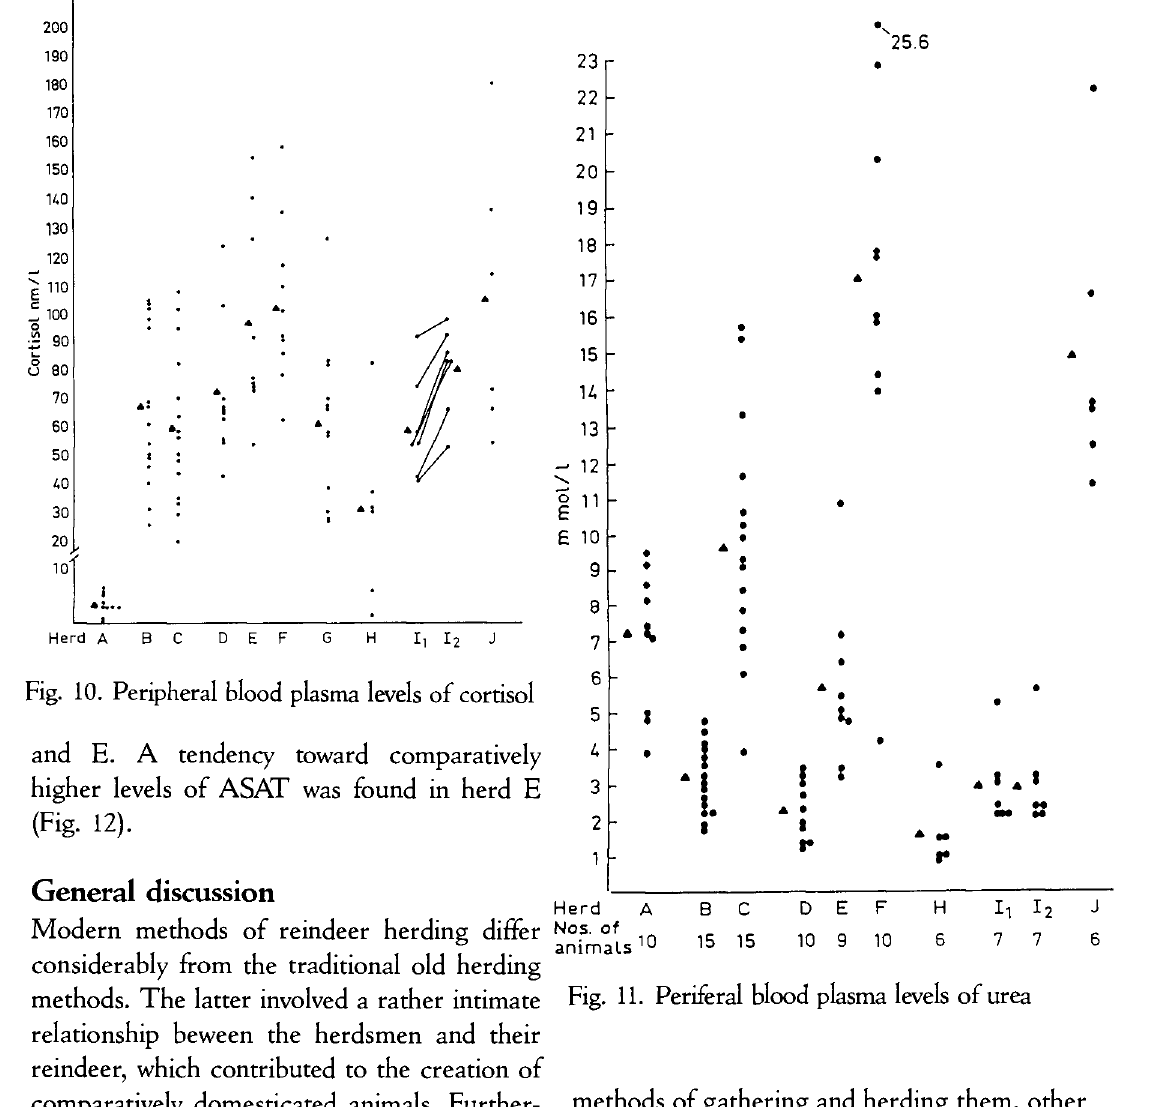
Fig. 11. Periferal blood plasma levels of